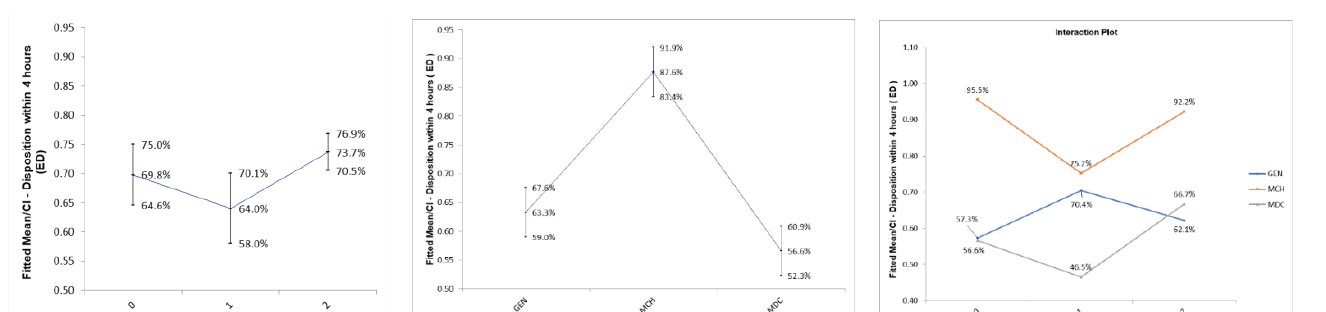
Figure 2. Effects plots for the percentage of patient seen within four hours in the emergency depart- ment (DTD) by hospital (GEN, MCH, MDC) and COVID-19 phase (pre (0), early (1), late (2)).